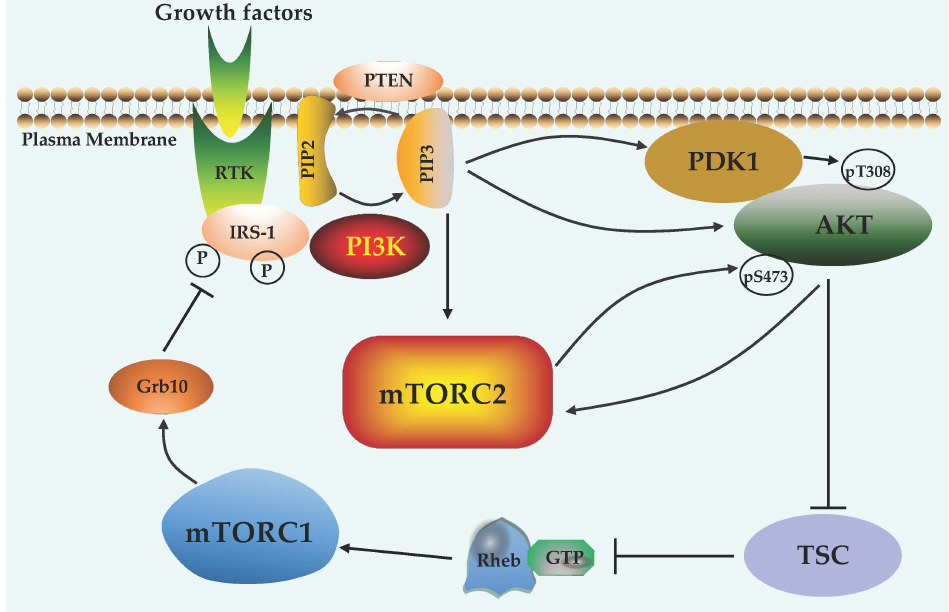
Figure 3. Crosstalk between mTOR signaling and PI3K/Akt pathway. Growth factors bind to receptor tyrosine kinase (RTK) and activate PI3K to convert PIP2 to PIP3, which can be reversed by PTEN. PIP3 recruits Akt to the plasma membrane for phosphorylation at T308 and S473 by PDK1 and mTORC2, respectively. Activated Akt suppresses TSC complex to promote GTP loading on Rheb for mTORC1 activation. In turn, mTORC1 phosphorylates Grb10 to inhibit RTK/PI3K activity. Thus, PI3K, Akt, and mTOR form a feedback regulatory